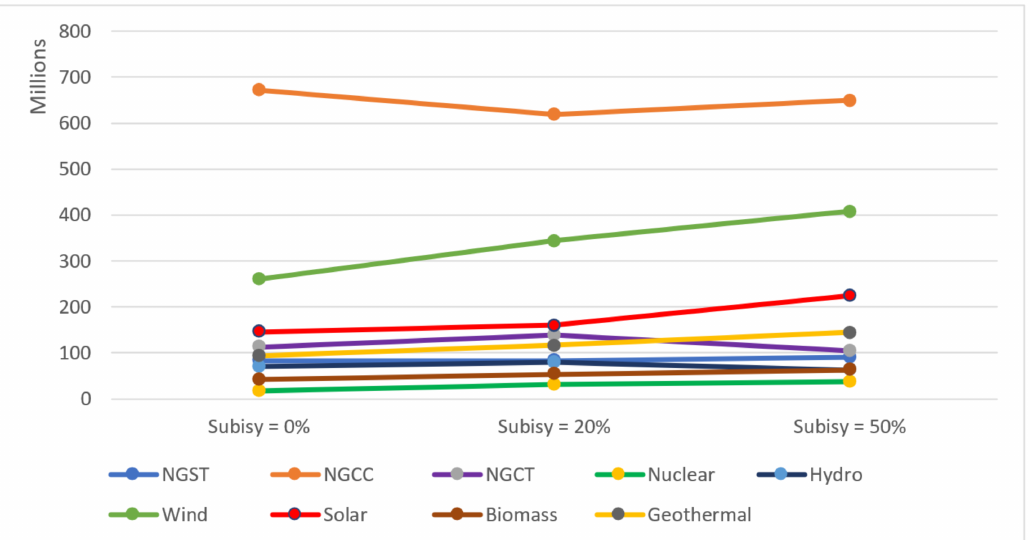
Figure 8. Sensitivity analysis of government subsidy value by power plants profit (Million $).